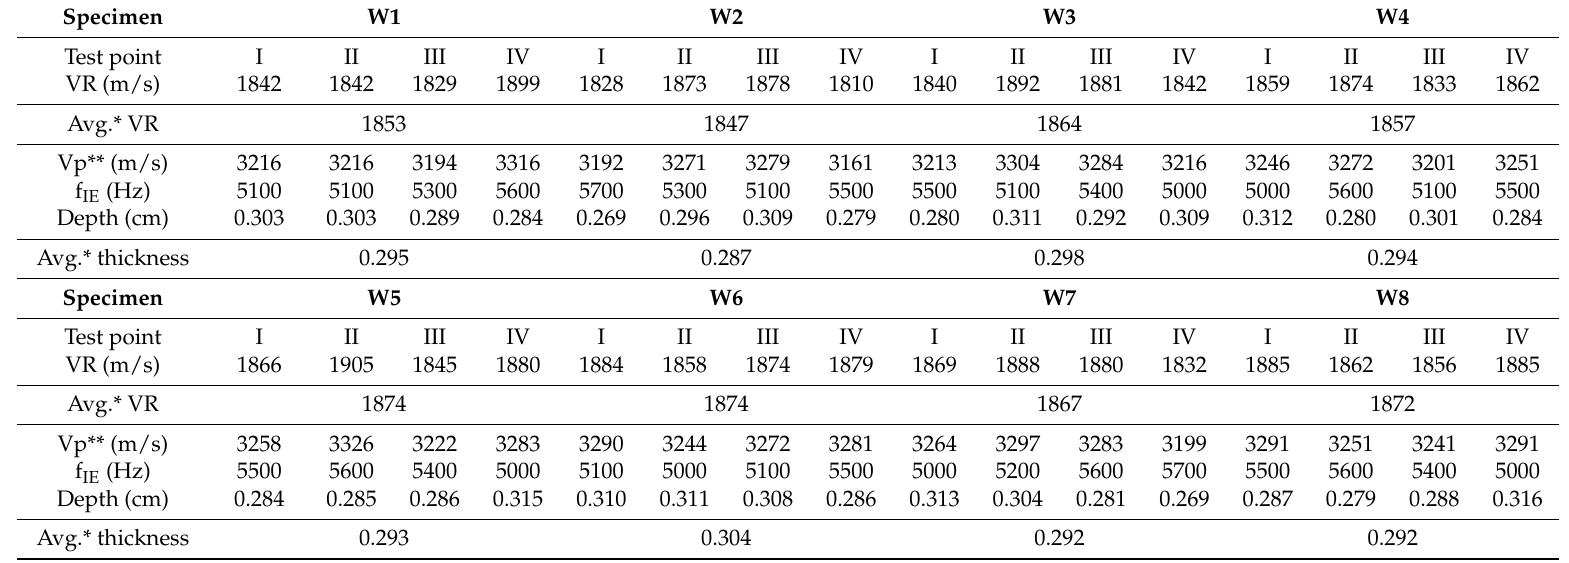
Table 1. The experimental results of MASW along four paths in all of the specimens. VR, Raleigh wave